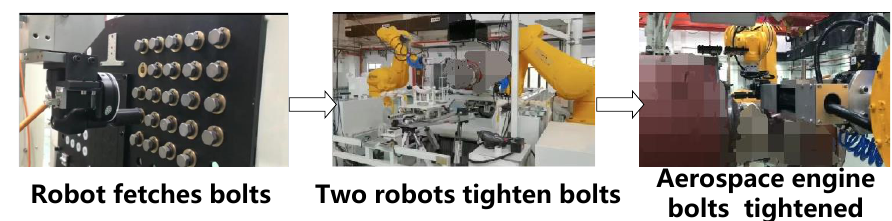
Figure 20. Bolt tightening of aerospace engine based on flexible